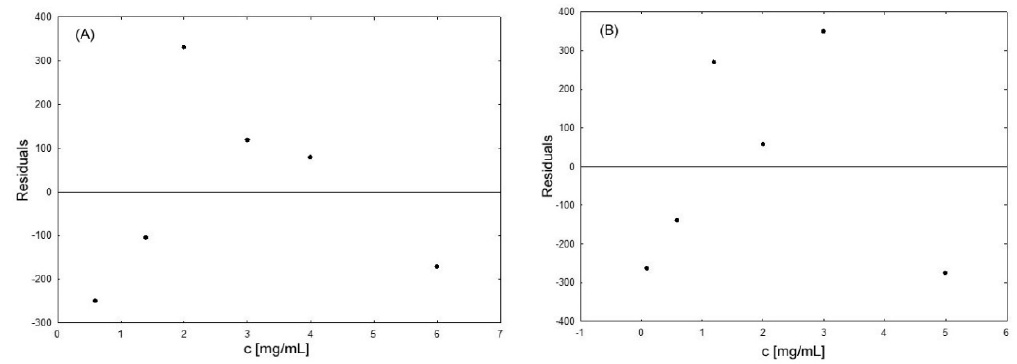
Figure 5. An example of the plot of residuals for firocoxib at 254 nm ( A ) and celecoxib at 290 nm ( B ).